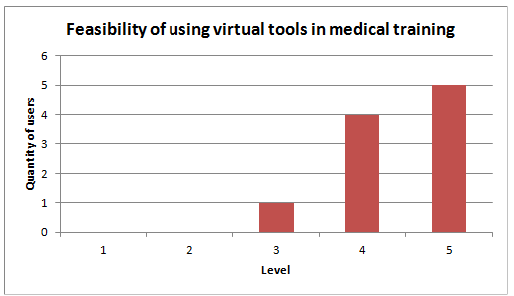
ViMeTGame evaluation question about using computational tools in medical training. Scale: 1 to “Do not believe”and 5 to “Totally believe”.